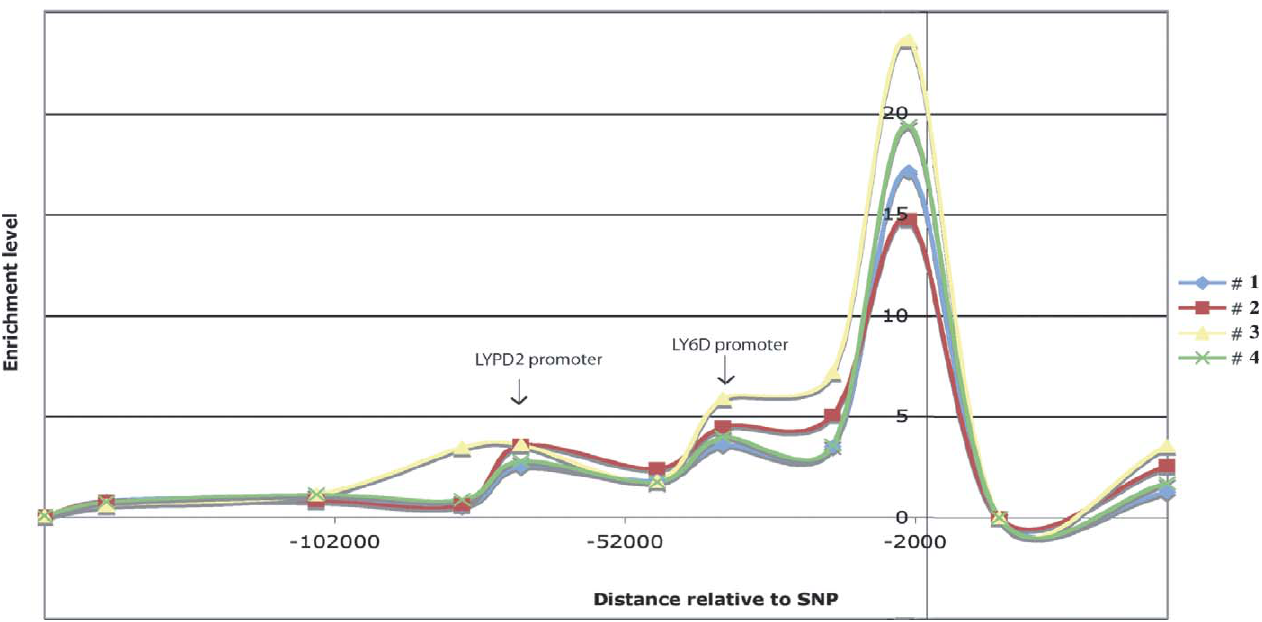
Figure 4. Long-Range Interactions between rs2572886 and LY6/uPAR Gene Promoters Curves show results of quantitative chromatin conformation capture (3C) for four independent CD4 þ cell lines. The y -axis corresponds to interaction enrichment relative to background (furthest point) and corrected according randomly ligated BAC. The x -axis shows relative distance to rs2572886.